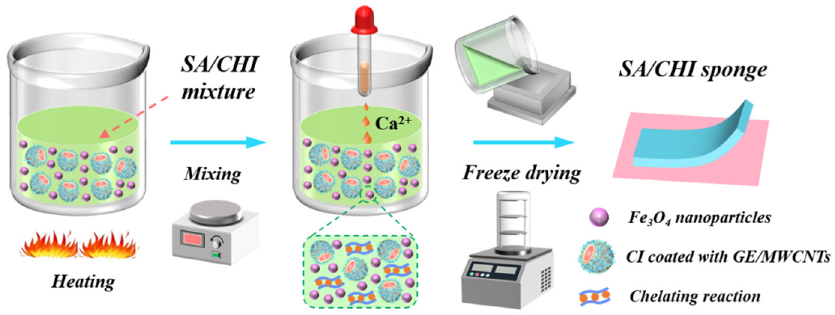
Figure 1. Fabrication procedures of the SA/CHI porous sponge. Table 1. Detailed parameters of SA/CHI porous sponge.